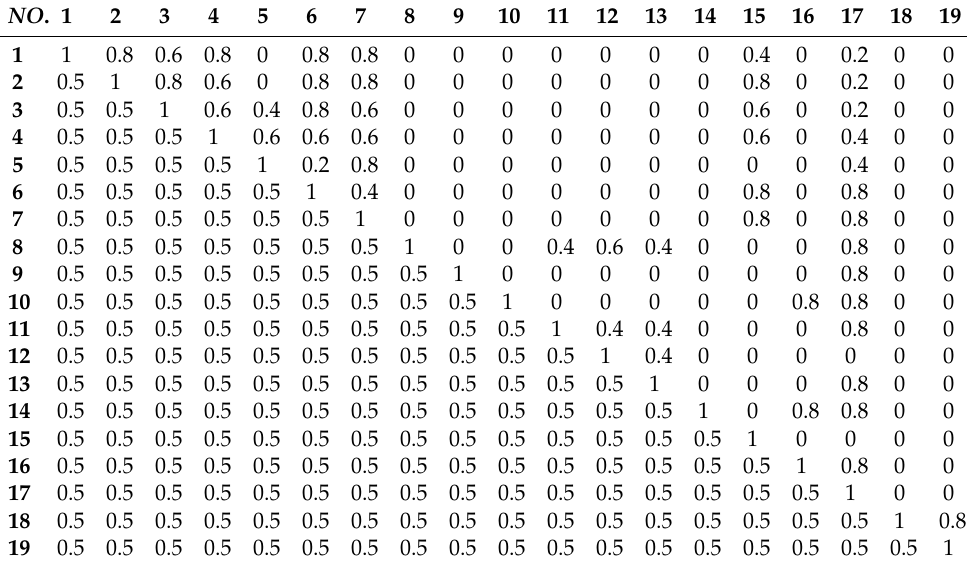
Table 8. Correlation coefficient matrix.